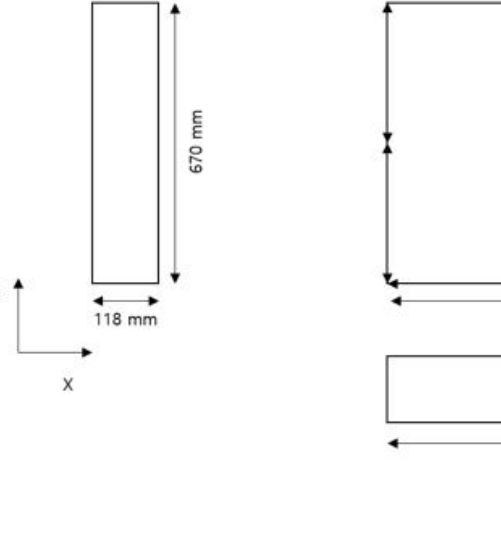
Figure 2. Model tank dimensions.